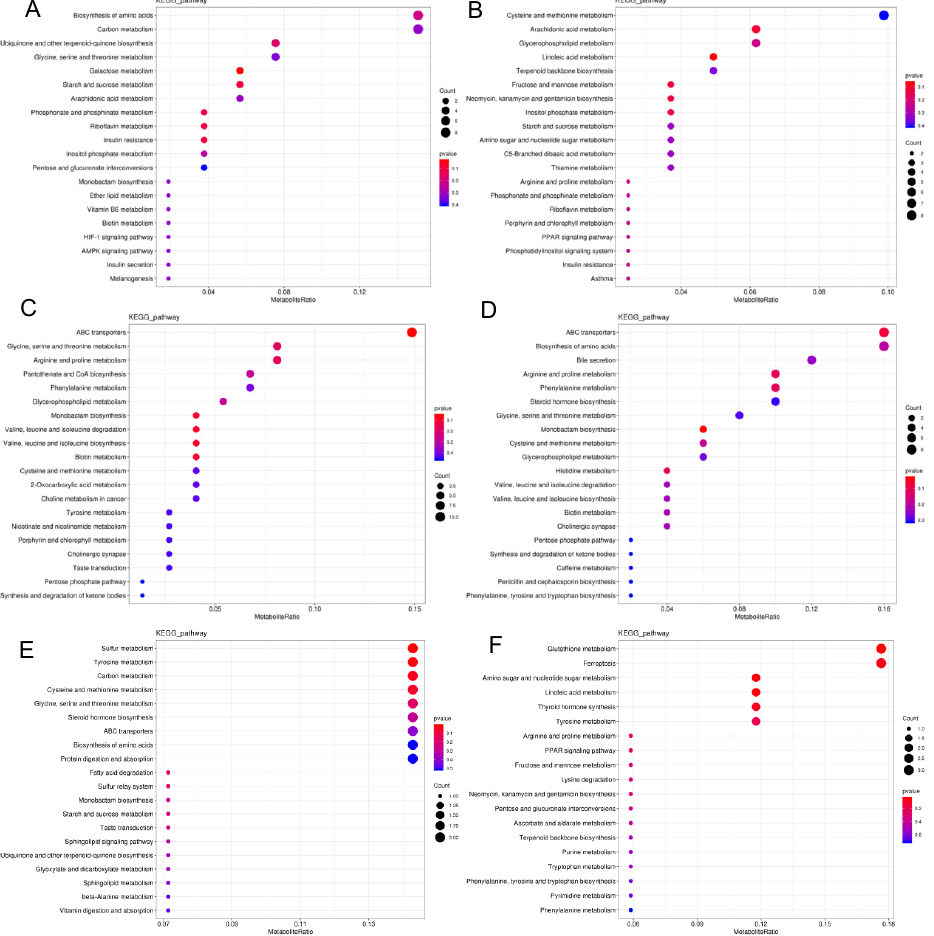
Figure 4 Summary of pathway analysis. (A) Pathway analysis of LC 10 and control groups at neg-mode. (B) Figure 4. Summary of pathway analysis. ( A ) Pathway analysis of LC 10 and control groups at neg-mode. Pathway analysis of LC 90 and control groups at neg-mode. (C) Pathway analysis of LC 10 and control groups at ( B ) Pathway analysis of LC 90 and control groups at neg-mode. ( C ) Pathway analysis of LC 10 and control neg-mode. (D) Pathway analysis of LC 90 and control groups at pos-mode. (E) Pathway analysis of LC 10 and LC 90 groups at pos-mode. ( D ) Pathway analysis of LC 90 and control groups at pos-mode. ( E ) Pathway analysis groups at neg-mode. (D) Pathway analysis of LC 10 and LC 90 groups at pos-mode.The color and size of the shapes of LC 10 and LC 90 groups at neg-mode. ( F ) Pathway analysis of LC 10 and LC 90 groups at pos-mode. The represent the regulated degree of the pathways by the treatment of doses of the spinetoram; larger, red shapes color and size of the shapes represent the regulated degree of the pathways by the treatment of doses of indicate a greater effect on the pathway. the spinetoram; larger, red shapes indicate a greater effect on the